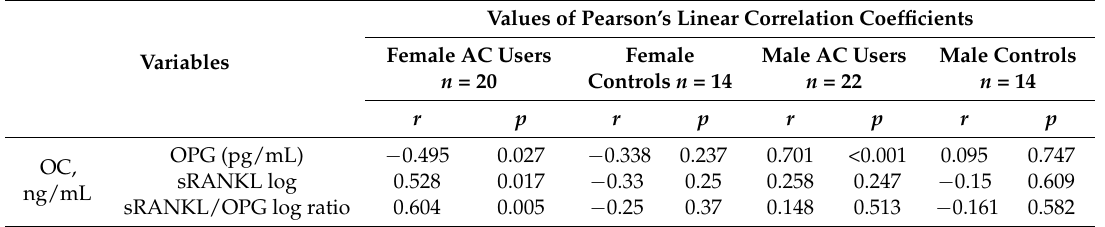
Table 3. Correlations between studied variables in female and male AC users, and gender-matched controls.